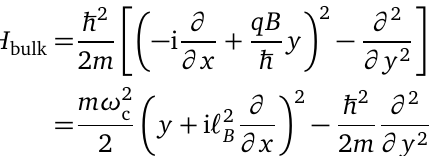
y . The total o = N L x x x p